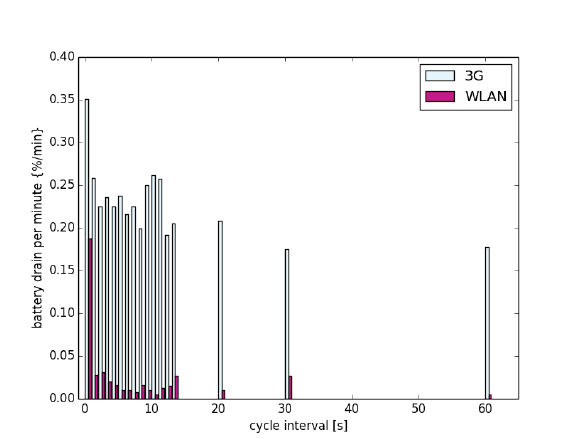
Figure 2. Comparison of battery drainage of 3G vs. WLAN, based on cycle